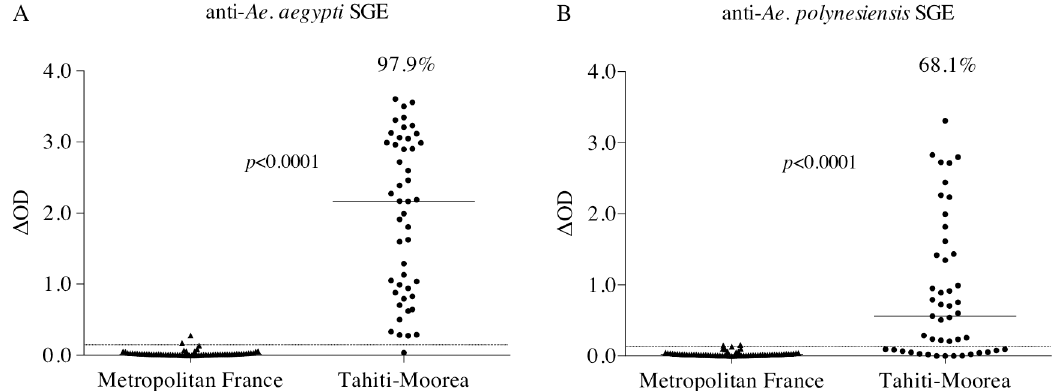
Fig 1. Antibody responses to Ae . aegypti and Ae . polynesiensis SGE in French Polynesian residents. The figure presents the individual IgG responses ( Δ OD)against Ae . aegypti (A) and Ae . polynesiensis (B) SGE in metropolitan France (n = 66) and in Tahiti and Moorea islands (French Polynesia, n = 47) residents. Each triangle or dot represents an individual sample and the horizontal bar indicates the median value. The dotted lines correspond to the positivity thresholds calculated from the cohort of metropolitan French residents, not exposed to these Aedes species (0.16 for Ae . aegypti and 0.13 for Ae . polynesiensis ). The percentage of responders (positive samples) in the Tahiti-Moorea cohort is shown above the plot. The non-parametric Mann-Whitney test was used to compare groups.